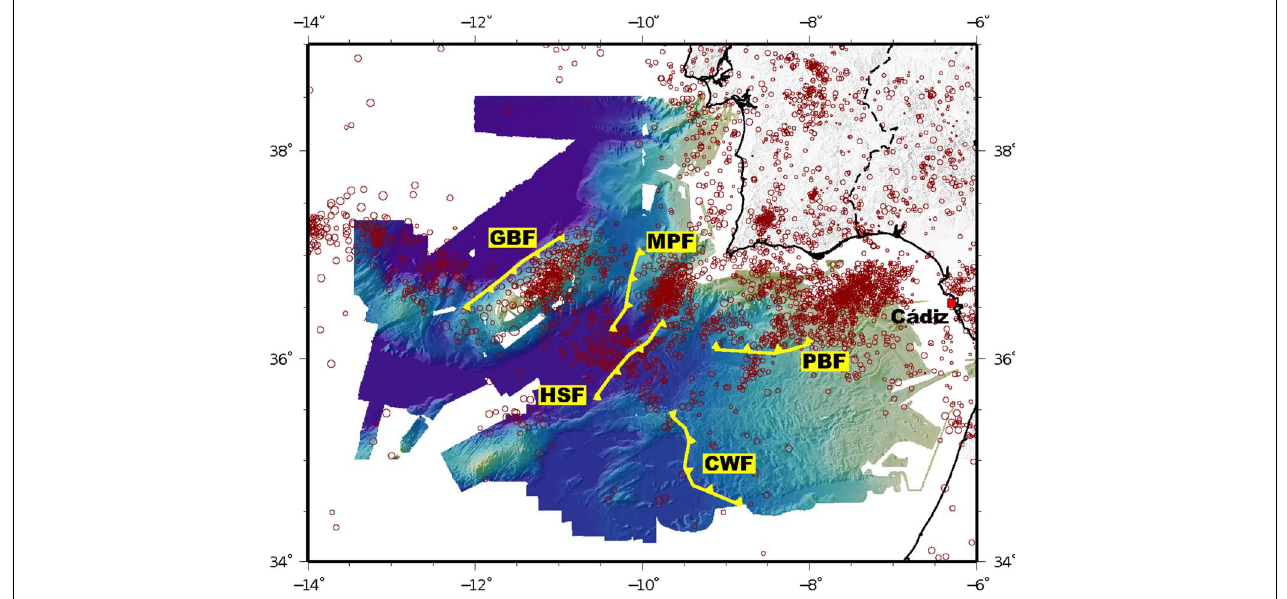
FIGURE 2 | Map of seismicity and geological structures used as sources in the present study. GBF, Gorringe Bank Fault; MPF, Marques de Pombal Fault; HSF, Horseshoe Fault; PBF, Portimao Bank Fault; CWF, Cádiz Wedge Fault. Circles show the epicenters of the Spanish National Seismic Network instrumental catalog, with the size proportional to the event magnitude. The colormap shows the SWIM high resolution bathymetry (Zitellini et al.,